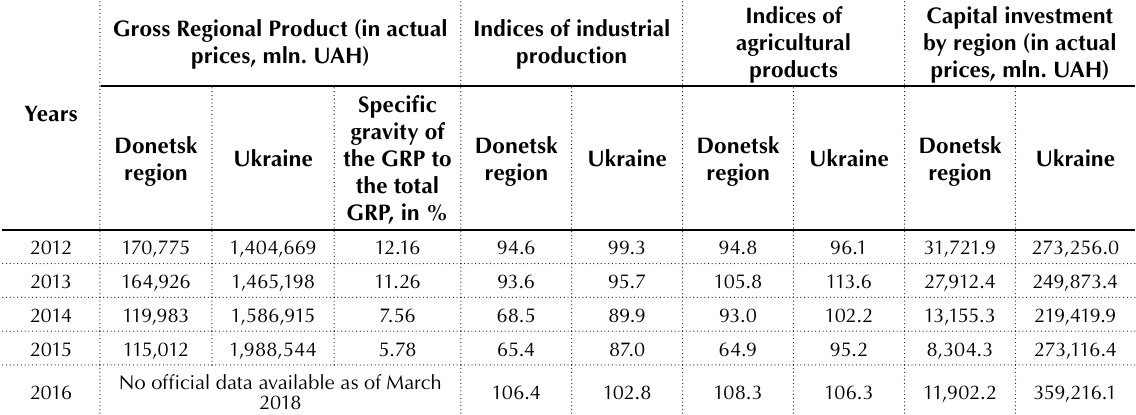
Source: State Statistics Service of Ukraine